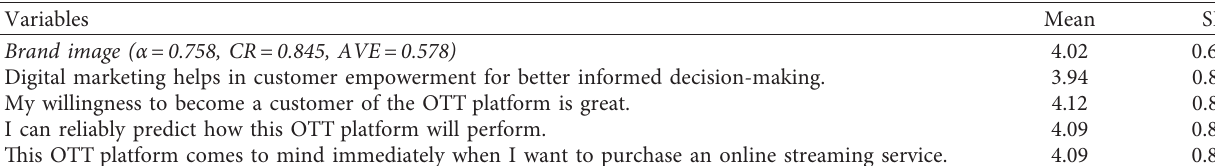
Table 6: Brand image.